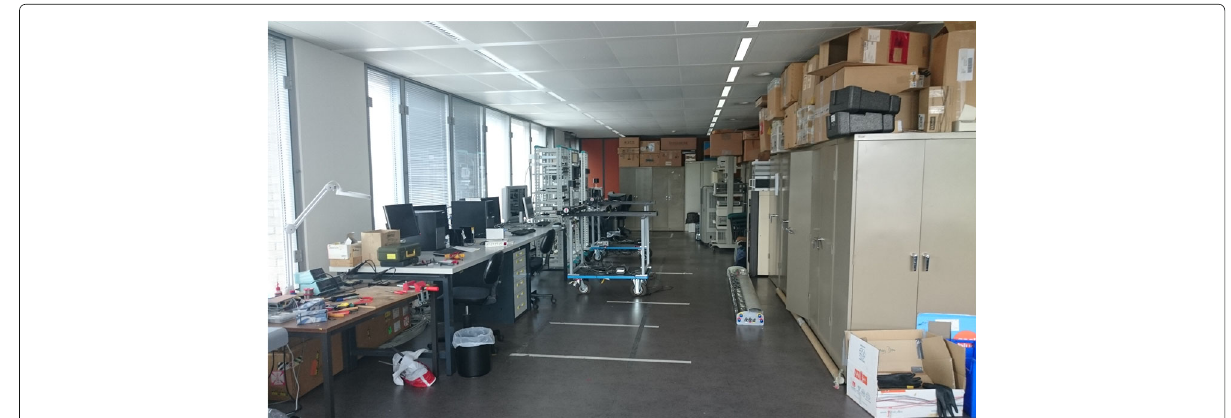
Fig. 11 Measurement environment: photograph of long